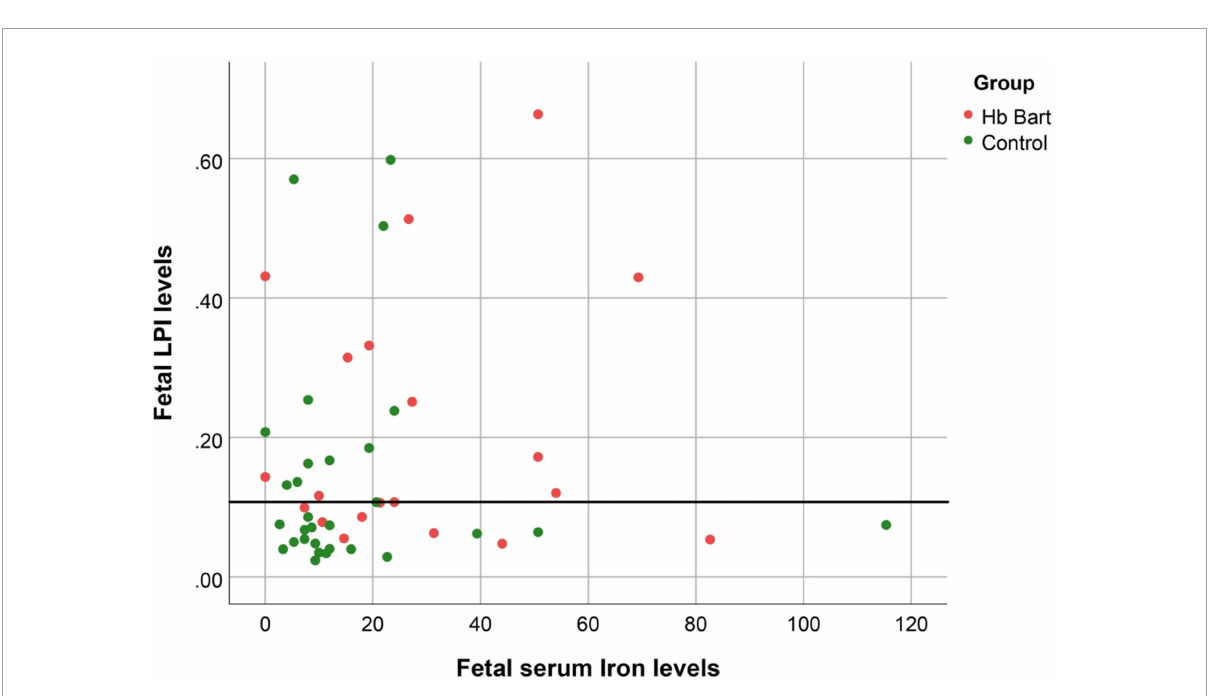
FIGURE2 The correlation between fetal LPI (Labile Plasma Iron) levels and fetal serum iron levels (S function; R 2 : 0.045; p : 0.138).